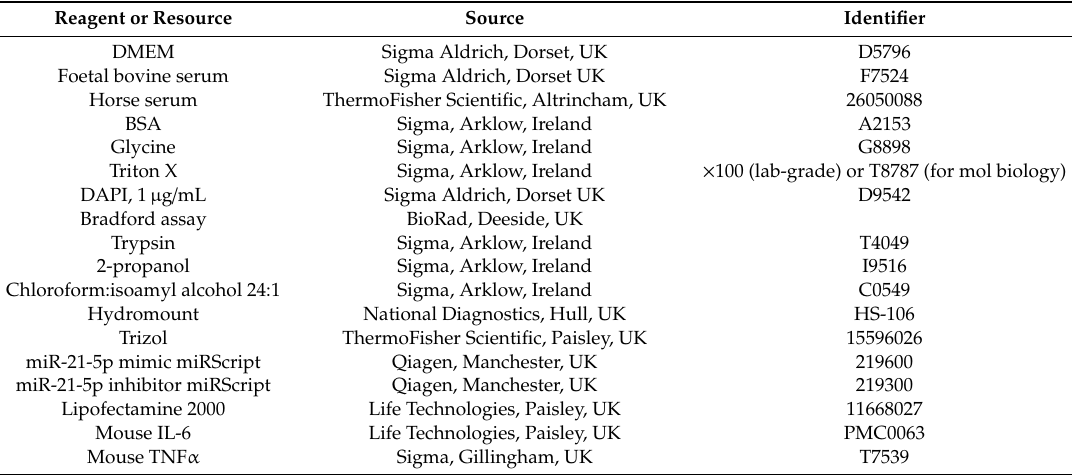
Table A1. Chemicals used in this study.